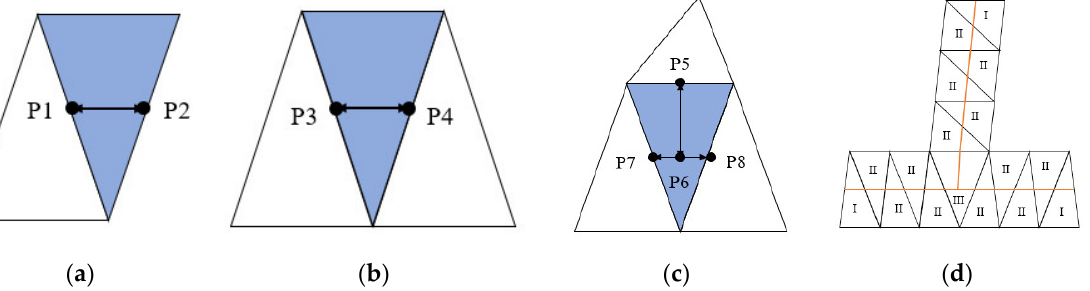
Figure 6. Centerline construction in different types of triangles. ( a ) Type I; ( b ) Type II; ( c ) Type III; ( d ) Centerline construction. ( d ) Centerline